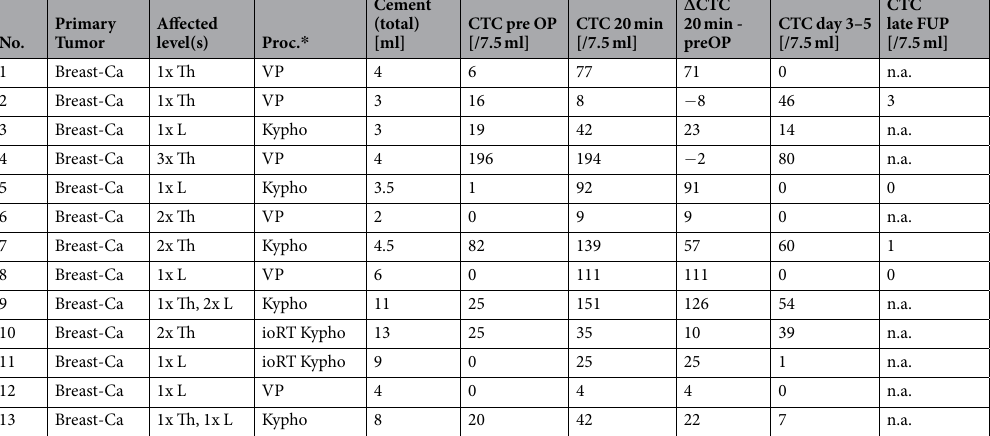
Table 1. CTCs in Patients with Breast-Ca Metastases. * VP = Vertebroplasty; Kypho = Kyphoplasty; ioRT Kypho = intraop radiation Kyphoplasty. Circulating tumour cell (CTC) counts of breast-cancer group according to procedure and level. L: lumbar, Th: thoracic.